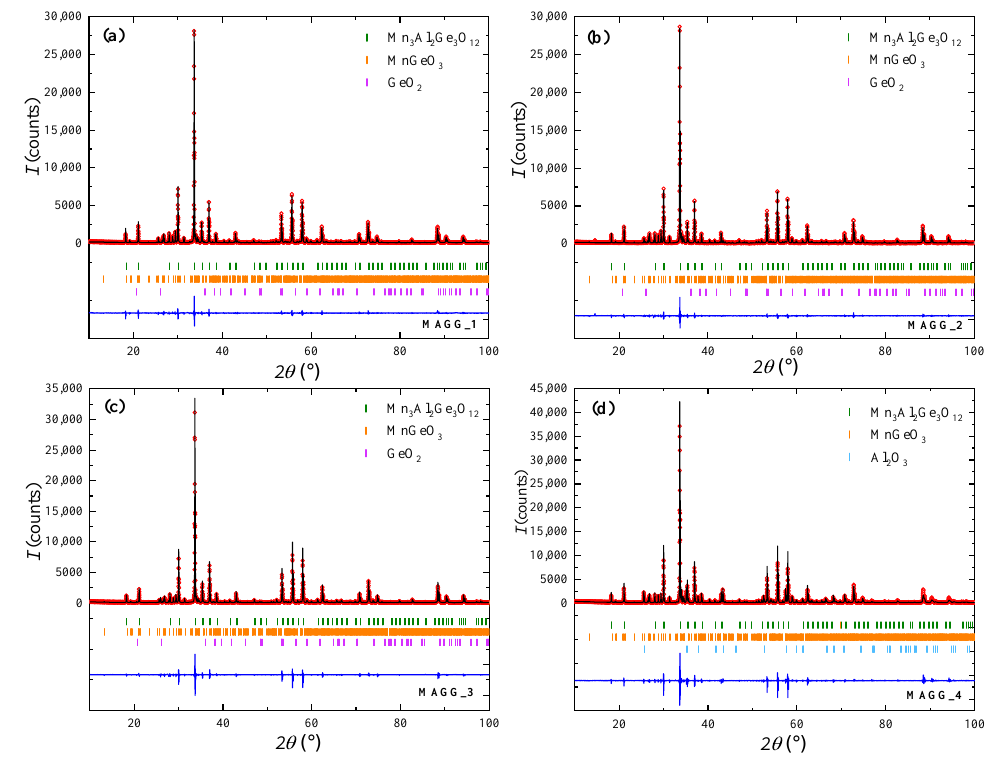
Figure 2. PXRD profiles of four of the polycrystalline Mn 3 Al 2 Ge 3 O 12 samples (labeled MAGG_1, MAGG_2, MAGG_3, and MAGG_4), prepared using different amounts of excess GeO 2 . ( a – c ) MAGG_1, MAGG_2 and MAGG_3, prepared using 5, 10 and 15% of GeO 2 excess, respectively, in three steps, at 900 ◦ C, 1100 ◦ C, and 1150 ◦ C for 24 h. ( d ) MAGG_4, prepared using 0% GeO 2 excess in three steps, at 900 ◦ C, 1100 ◦ C, and 1150 ◦ C for 48–72 h. The red open circles represent the experimental profiles and the black lines are the calculated profiles, with the difference given by the blue lines. The reflections of the cubic Mn 3 Al 2 Ge 3 O 12 garnet structure are indicated by green “ (cid:120) ” while orthorhombic ( Pbca ) MnGeO 3 , trigonal ( P 3 2 21) GeO 2 and rhombohedral ( R ¯3 c ) Al 2 O 3 are represented using orange, pink and light blue “ (cid:120) ” respectively.